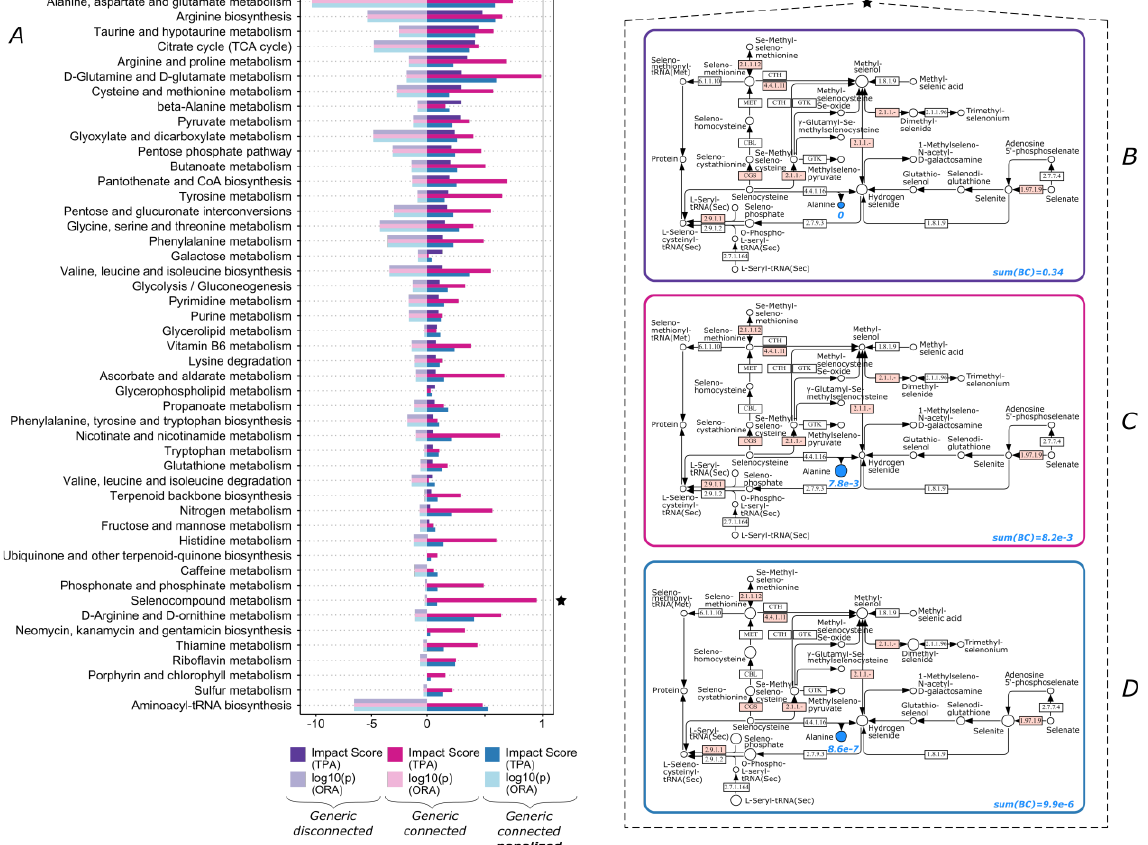
Figure 5. Pathway scoring comparison for dataset 4. ( A ) TPA impact scores and ORA log10(p) values for all pathways (pathways exhibiting zero values in all cases are omitted). ★ “Selenocompound metabolism” pathway for ( B ) generic disconnected, ( C ) generic connected, and ( D ) generic connected with penalization scheme. Blue color denotes significant compounds in this dataset, blue values are the computed betweenness centrality scores for these nodes, sum(BC) is the sum of betweenness centrality scores for all the nodes of the pathway, and node size corresponds to the relevant betweenness centrality scores of the nodes within the pathway. White and pink boxes denote human native and non-human native enzymatic reactions, respectively.